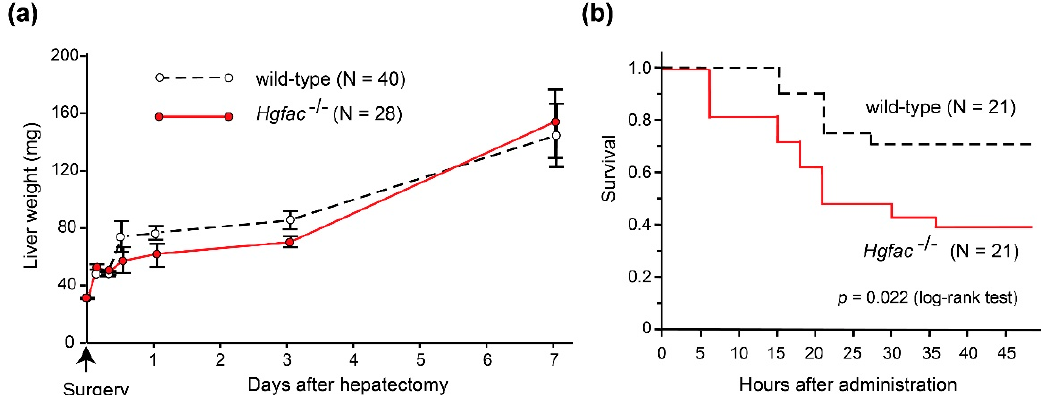
Figure 2. Effects of Hgfac deletion on liver regeneration and survival of C57BL6 mice after partial hepatectomy ( a ) and CCl 4 treatment ( b ). ( a ) Effect of Hgfac deletion on liver weight gain after 70% partial hepatectomy. N = 40 for wild-type mice and 28 for Hgfac − / − mice on the 7th day. No significant differences between two groups (two way repeated-measures analysis of variance). ( b ) Effect of Hgfac deletion on the survival of mice after CCl 4 administration (2.5 µ L/g, intraperitoneal injection). Kaplan-Meier survival curve is shown. *, p = 0.0216 (log-rank test); N = 21 for each group. All mice were